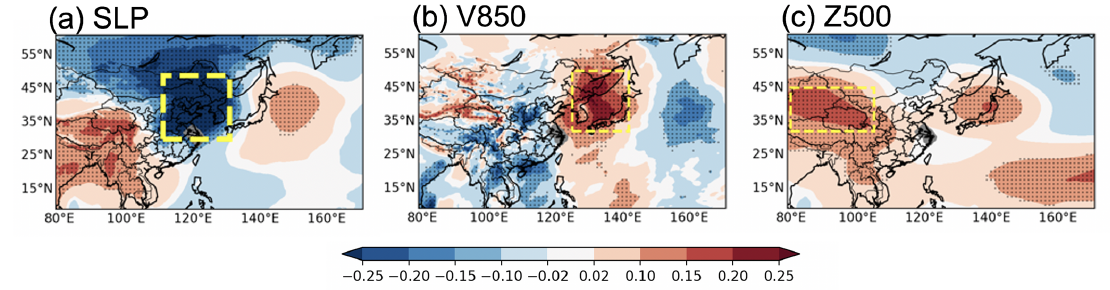
Figure 7. Correlation coefficients of daily PM 2 . 5 concentrations in YRD with 1d before (a) SLP, (b) V850 and (c) Z500 during DJF 2013– 2017 (dotted regions indicate significant correlations at the 95% level from the two-tailed Student’s t test). Grey shading represents the YRD region. The broad region presenting the highest correlation with YRD is marked by a yellow rectangle in each panel. The region used for the definition of a circulation-based index (Eq. 4) is marked by a yellow thick rectangle in (a)